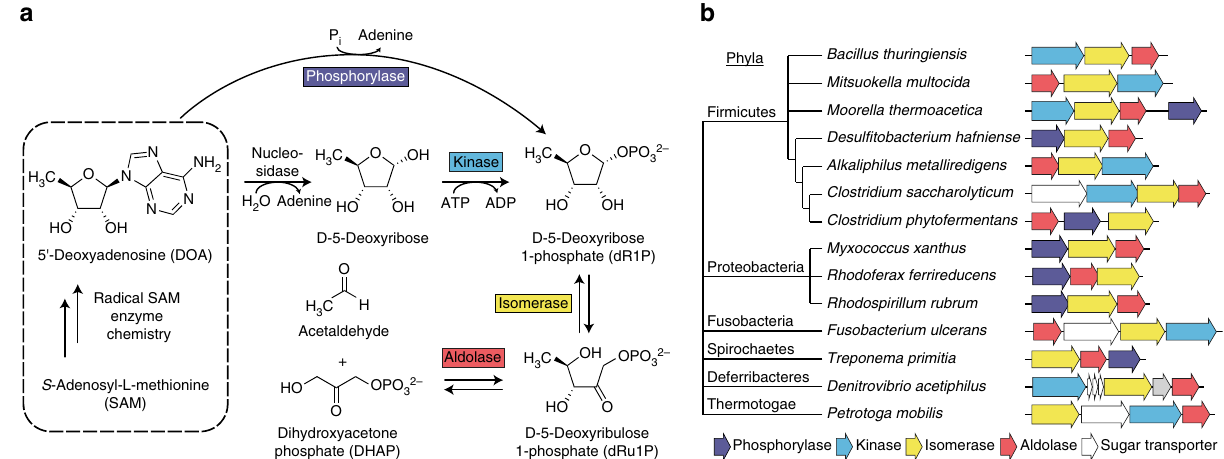
Fig. 1 Potential routes of 5 ′ -deoxyadenosine metabolism and gene clusters predicted to encode them. a 5 ′ -Deoxyadenosine is converted to dR1P by a phosphorylase, or by a nucleosidase plus a kinase. dR1P is then metabolized to DHAP and acetaldehyde by the sequential action of an isomerase and an aldolase. b Gene clusters in genomes from six bacterial phyla that encode enzymes similar to 5-methylthioribose kinase or 5 ′ -methylthioadenosine phosphorylase, 5-methylthioribose 1-phosphate isomerase, and fuculose 1-phosphate aldolase, a class II aldolase. Four of the clusters shown also include one or more putative sugar transporter genes. The sugar transporter genes in Denitrovibrio acetiphilus are not drawn to scale. The gray gene in D. acetiphilus is homologous to fucose mutarotase NATURE COMMUNICATIONS| (2018) 9:3105 |DOI: